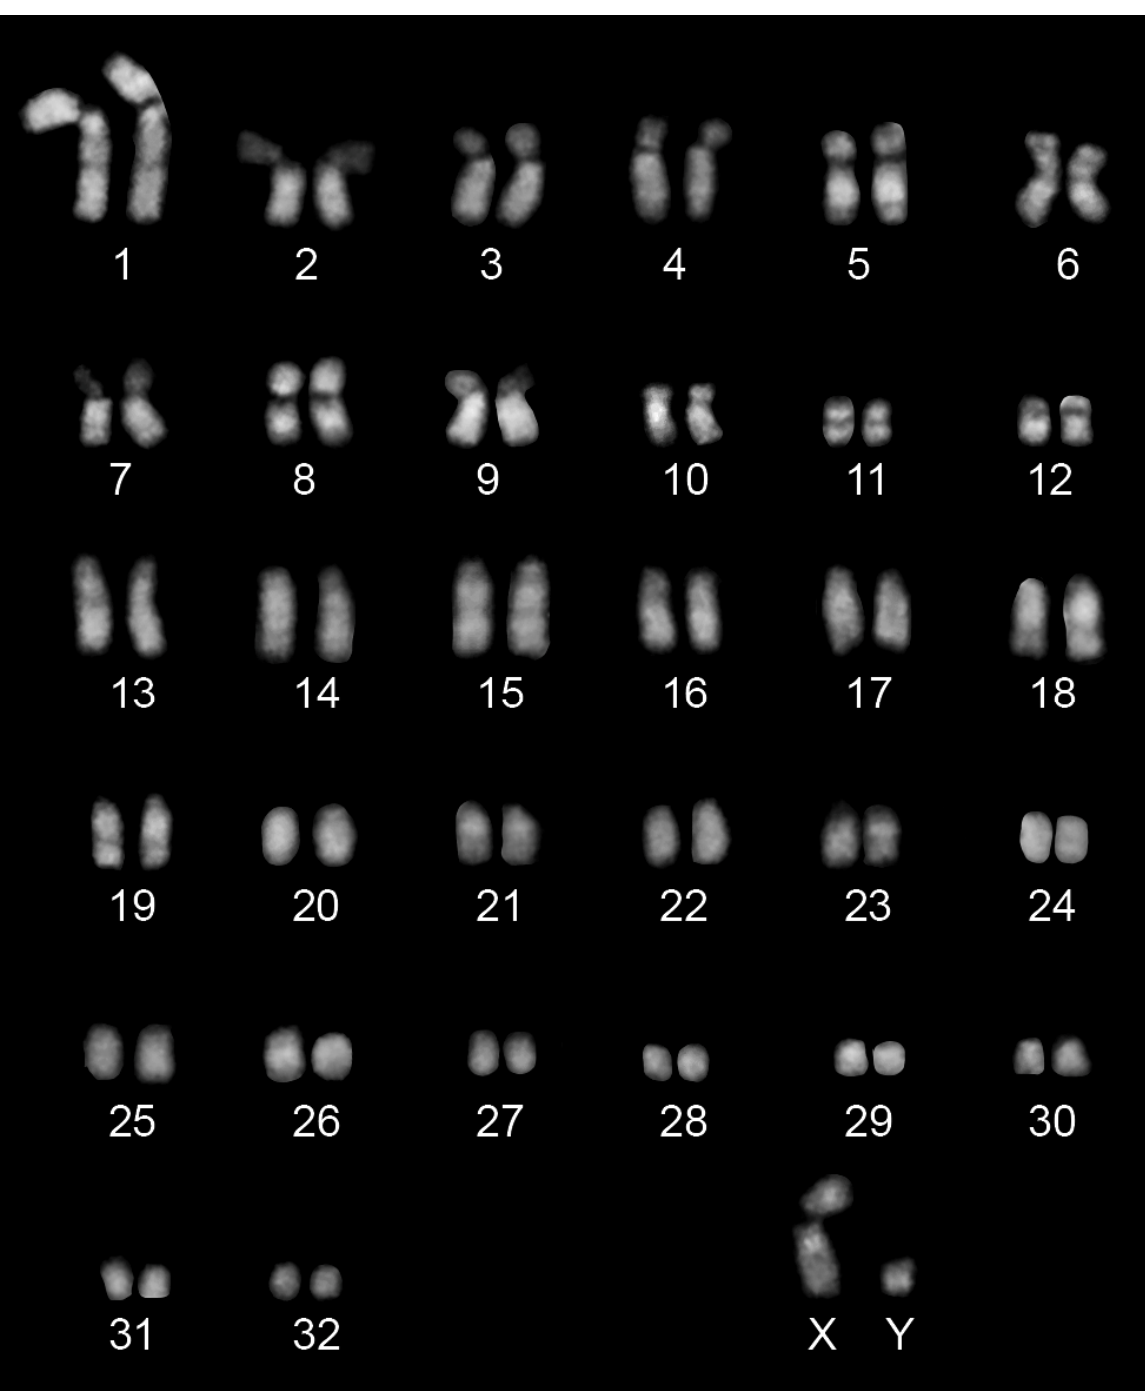
Figure 1. DAPI-banded karyotype of a male Equus przewalskii . The karyotype (2n = 66) consists of 24 biarmed autosomes, 40 acrocentric autosomes, a biarmed X chromosome, and the acrocentric Y chromosome. Chromosomes are arranged and numbered according to standard nomenclature.